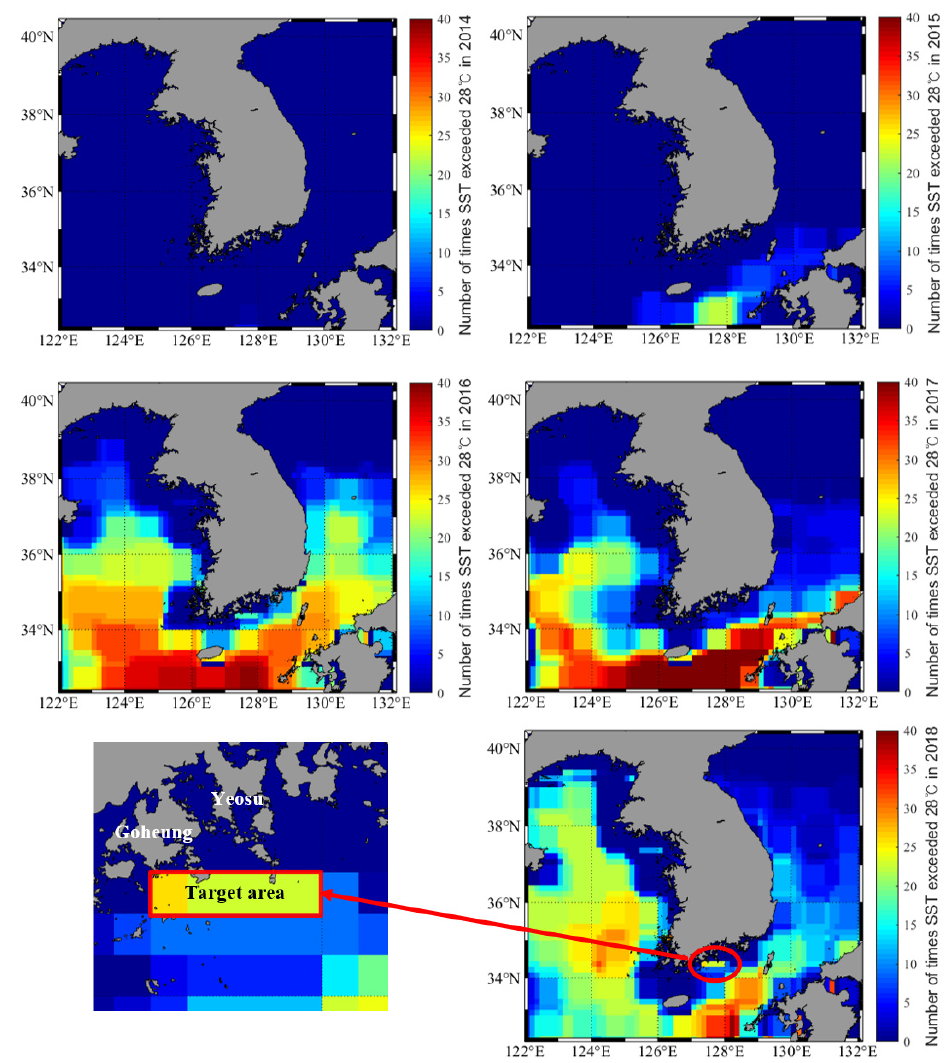
Figure 1. Incidence number of sea surface temperature (SST) readings exceeding 28 °C in the seas around the Korean Peninsula from 2014 to 2018 and the target area selected for high water temperature (HWT) prediction.